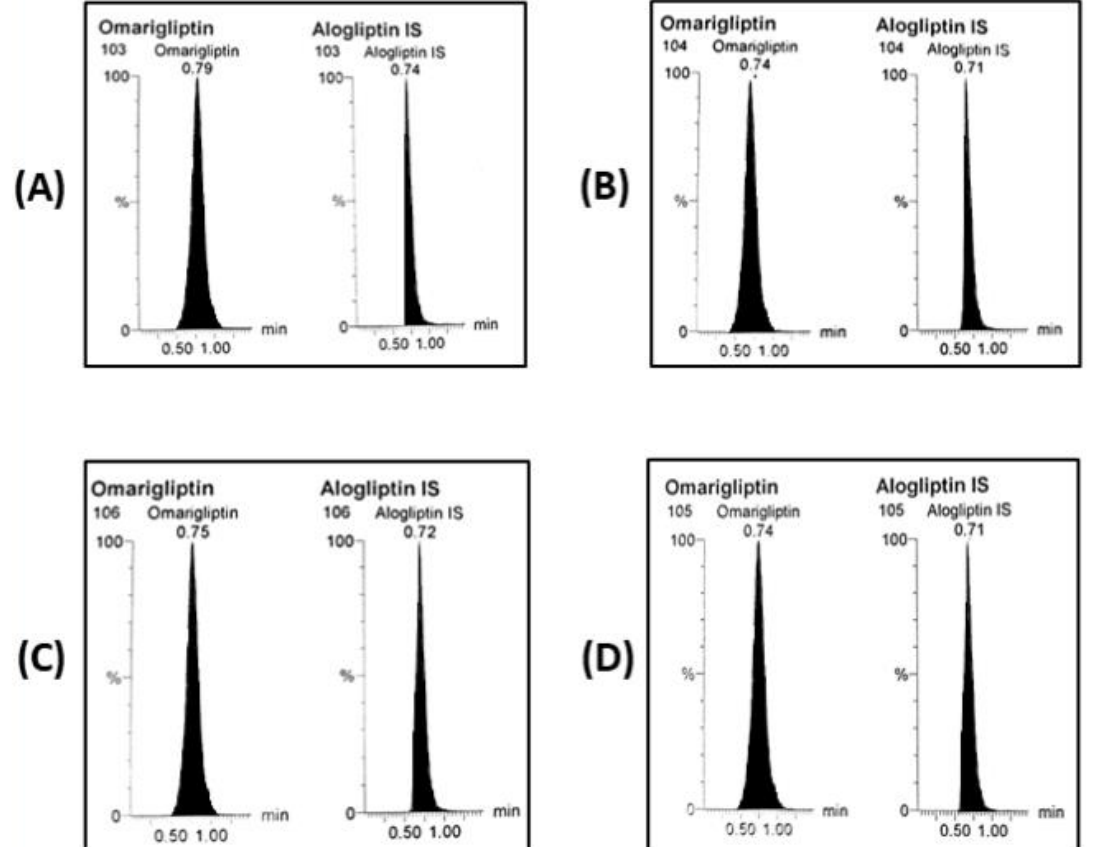
Figure 5. MRM chromatograms of OMR and IS ( A ) LLOQ plasma sample, ( B ) LLOQ brain homogenate sample, ( C ) biological plasma sample after 28 days multiple doses of OMR (5 mg/kg/day, p.o.), and ( D ) biological brain homogenate sample after 28 days multiple doses of OMR (5 mg/kg/day, p.o.).